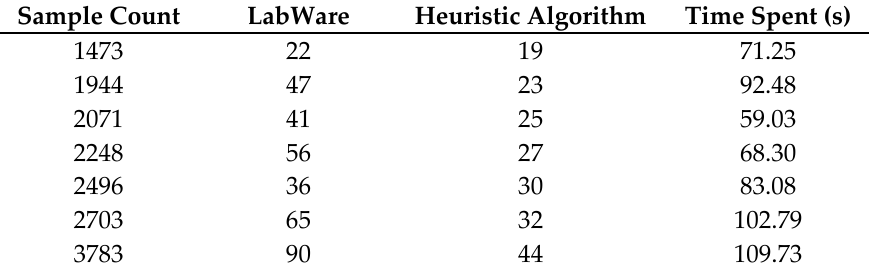
Table 1. Results and